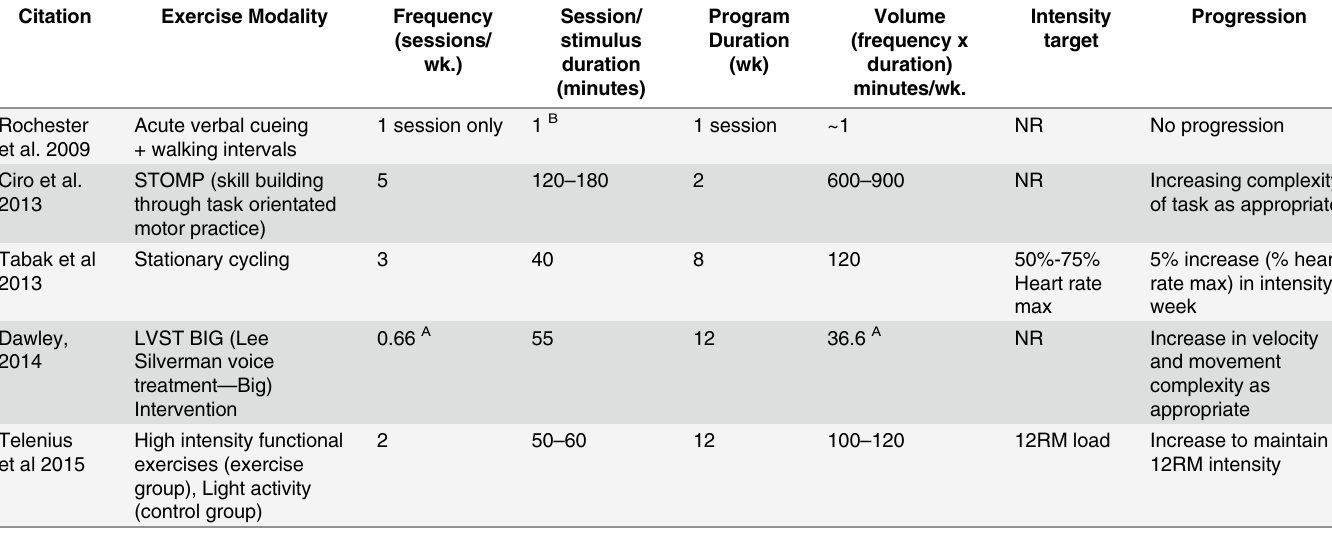
Table 5. Intervention Characteristics. NR — Not